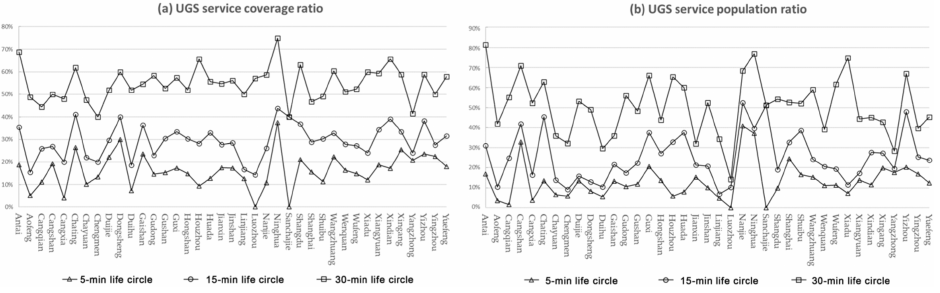
Figure 8. UGS service capability under different traveling scopes. ( a ) UGS service coverage ratio. ( b ) UGS service population ratio.